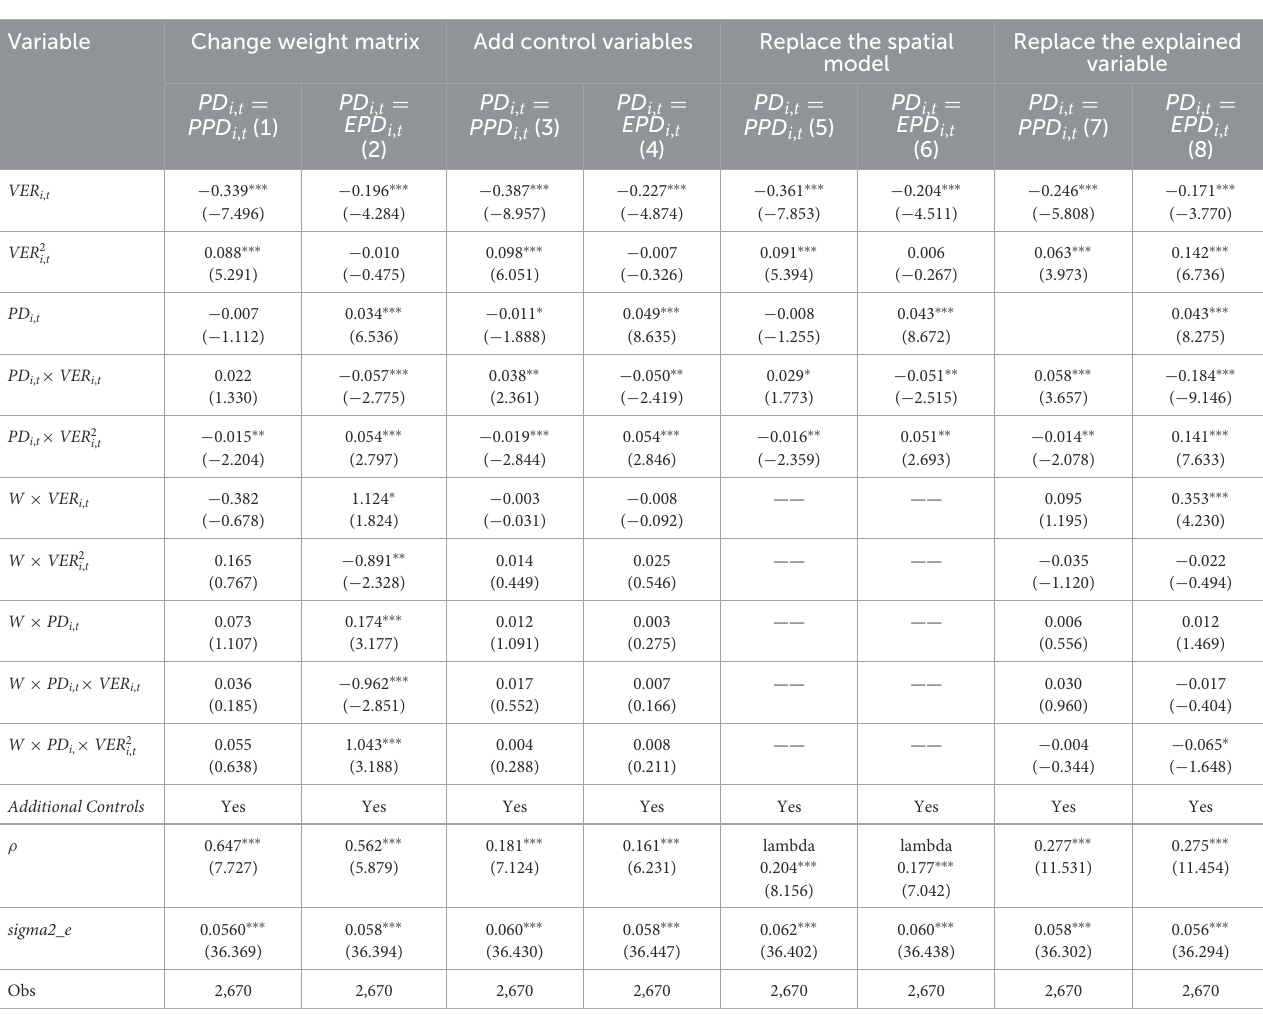
TABLE 9 The robustness test of the moderating effect of PD on the green governance effect of VER. Variable Change weight matrix Add control variables Replace the spatial